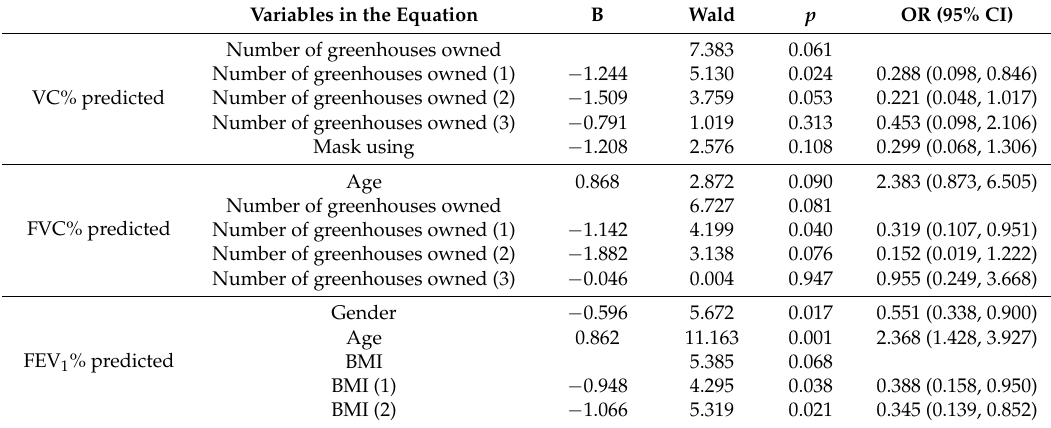
Table 3. Influence factors of lung ventilation function among greenhouse